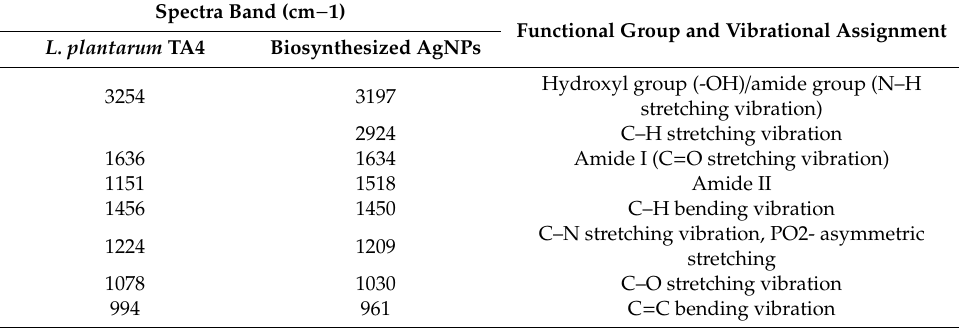
Figure 5. FTIR spectrum of the L. plantarum TA4 biomass (blue line) and the biosynthesized AgNPs (black line). Table 2. Main spectra bands and functional groups interpretation of L. plantarum TA4 and biosynthesized AgNPs.